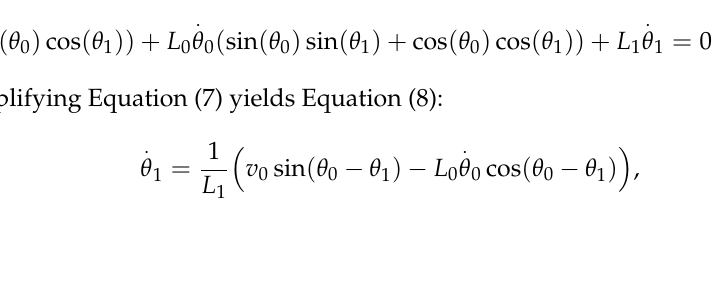
Multiplying the first formula of Equation (6) by sin ( θ 1 ) at both ends and the second formula by cos ( θ 1 ) at both ends, then subtracting the second formula from the first, gives Equation